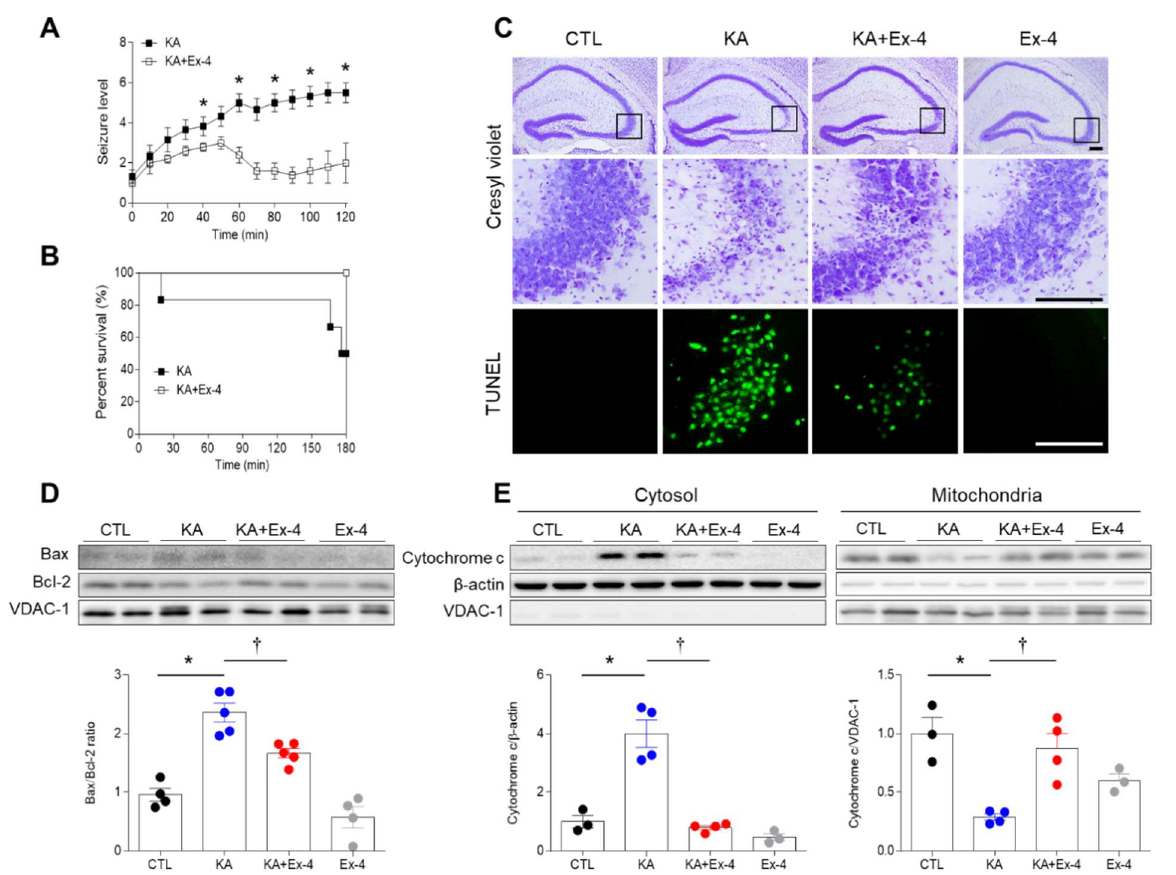
Figure 2. Effects of Ex-4 pretreatment on seizure activity and hippocampal cell death in KA-treated mice. ( A ) Seizure activity was measured during the two-hour monitoring period following KA injection. ( B ) The percentage of survival in KA and KA + Ex-4 group are shown ( n = 8–10 mice per group). ( C ) Representative images of Cresyl violet and TUNEL staining are shown in the hippocampal CA3 region 24 h after KA treatment. The areas in black squares in the upper panel are magnified on the middle panel. Scale bar = 200 µm, 50 µm. ( D ) Western blot analysis of hippocampal Bax and Bcl-2 expression. Densitometric values were normalized to the Bax/Bcl-2 ratio in the CTL group ( n = 4–5 mice per group). ( E ) Western blot analysis of hippocampal cytochrome c protein expression. Mitochondria fraction and cytosol were obtained by subcellular fractionation. Densitometric values for cytosolic and mitochondrial cytochrome c were normalized to β-actin and voltage-dependent anion-selective channel-1 (VDAC-1) levels ( n = 3–4 mice per group). Data are presented as mean ± SEM. * p < 0.05 vs. CTL, † p < 0.05 vs. KA. The t-test was used to detect statistically significant differences between KA- and KA+Ex-4-treated mice ( A ). The one-way ANOVA was used to detect any statistically significant differences between groups ( D and E ). Bax/Bcl-2; p values = 0.0001 (KA), 0.0096 (KA+Ex-4), F (3, 14) = 33.22, Cytochrome c/β–actin; p values = 0.0002 (KA), 0.0001 (KA+Ex-4), F (3, 10) = 33.01, Cytochrome c/VDAC-1; p values = 0.0024 (KA), 0.0054 (KA+Ex- 4), F (3, 10) = 10.63.